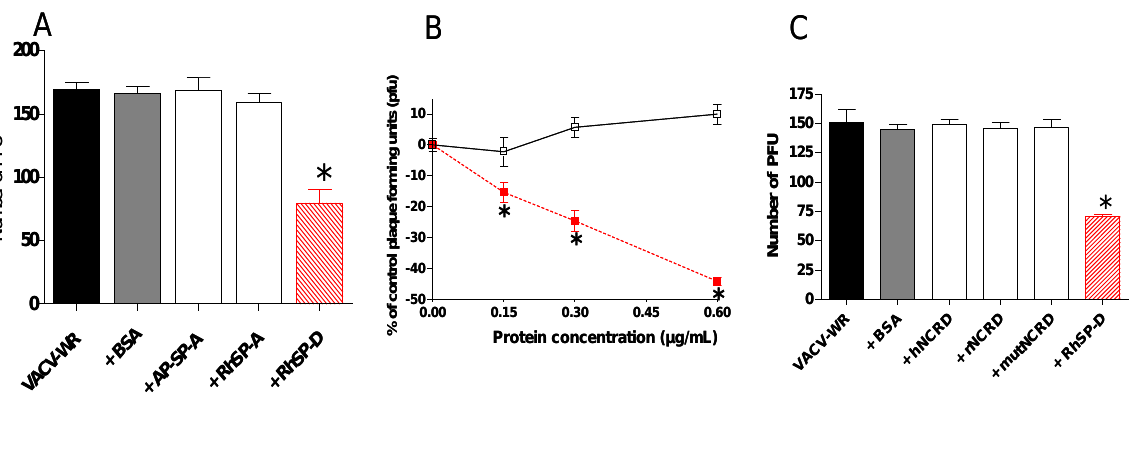
Figure 2. Virus infection inhibition assay. VACV-WR was incubated with proteins for 1 h. A549 cells were infected at a MOI of 0.0001 and virus replication was measured by a PFU assay. VACV-WR pre-treated groups were compared to the VACV-WR group. An asterisk indicates a statistically significant difference (p<0.05, two-tailed unpaired t-test). Incubation (A) with 0.6 µg/mL of BSA, AP-SP-A, RhSP-A or RhSP-D; (B) with increasing RhSP-D doses. Symbols: ■, VACV-WR+RhSP-D; □, VACV-WR+BSA. (C) VACV-WR was incubated with 0.6 µg/mL of RhSP-D and 2 µg/mL of NCRD domain of SP-D from human (hNCRD), rat (rNCRD), or human E31K mutant (mutNCRD) for 1